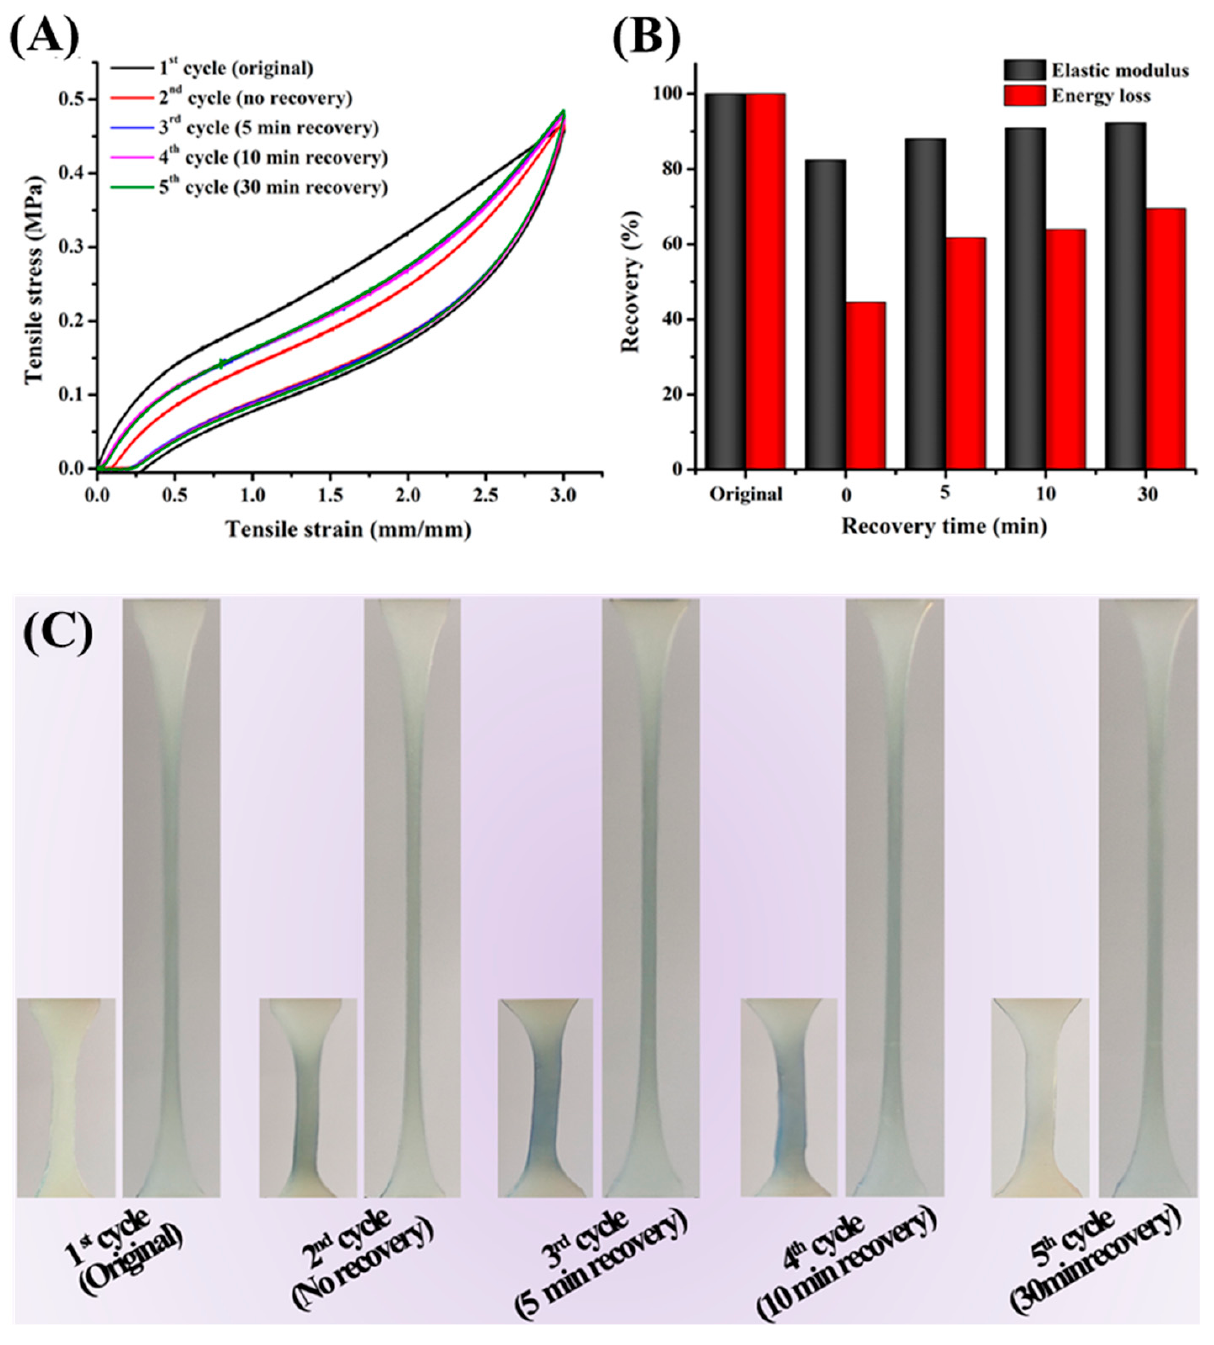
Figure 6. Force-induced color change and mechanical recovery of AM 25 –DMSP3 0.4 –MA 25 hydrogels using cyclic loading–unloading tests, as demonstrated by ( A ) hysteresis loading–unloading tests; and ( B ) toughness (energy loss) and stiffness (elastic modulus) recovery; ( C ) visual inspection of color change and recovery.